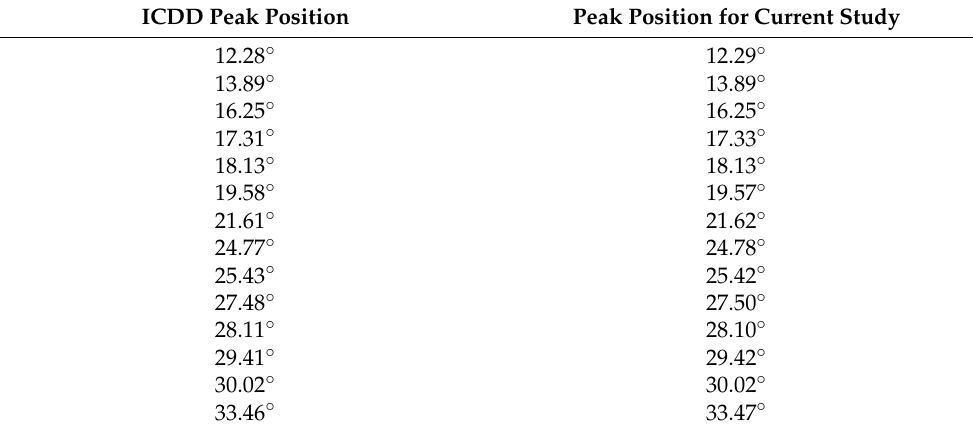
Figure 6. The XRD transmission diffractograms of the pure materials - CARB, CARR, SA, HPMC, and MTz. There were no sharp peaks for CARB, which showed a broad peak from a 2 θ of 15° to 25°, confirming its amorphous nature. MTz showed multiple intense sharp peaks be- tween a 2 θ of 12° to 35°, confirming that MTz is a solid in crystalline form. The main peaks for MTz observed in this study were compared to the corresponding reference peaks in as shown in Table 6 below. Table 6. The main reference peaks from the International Centre for Diffraction Data ( ICDD ® ) for MTz (ICDD PDF 38-1556) compared to those obtained from the current study in 2 θ .